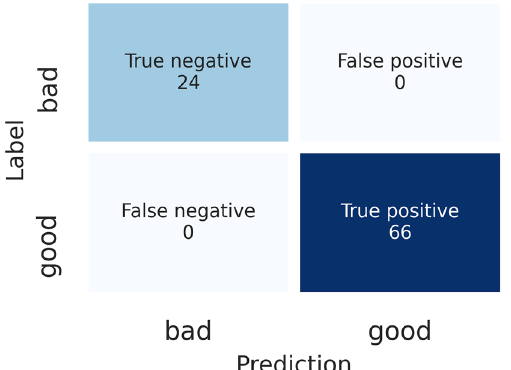
Figure 7. Confusion matrix for overall printing quality validation data set.